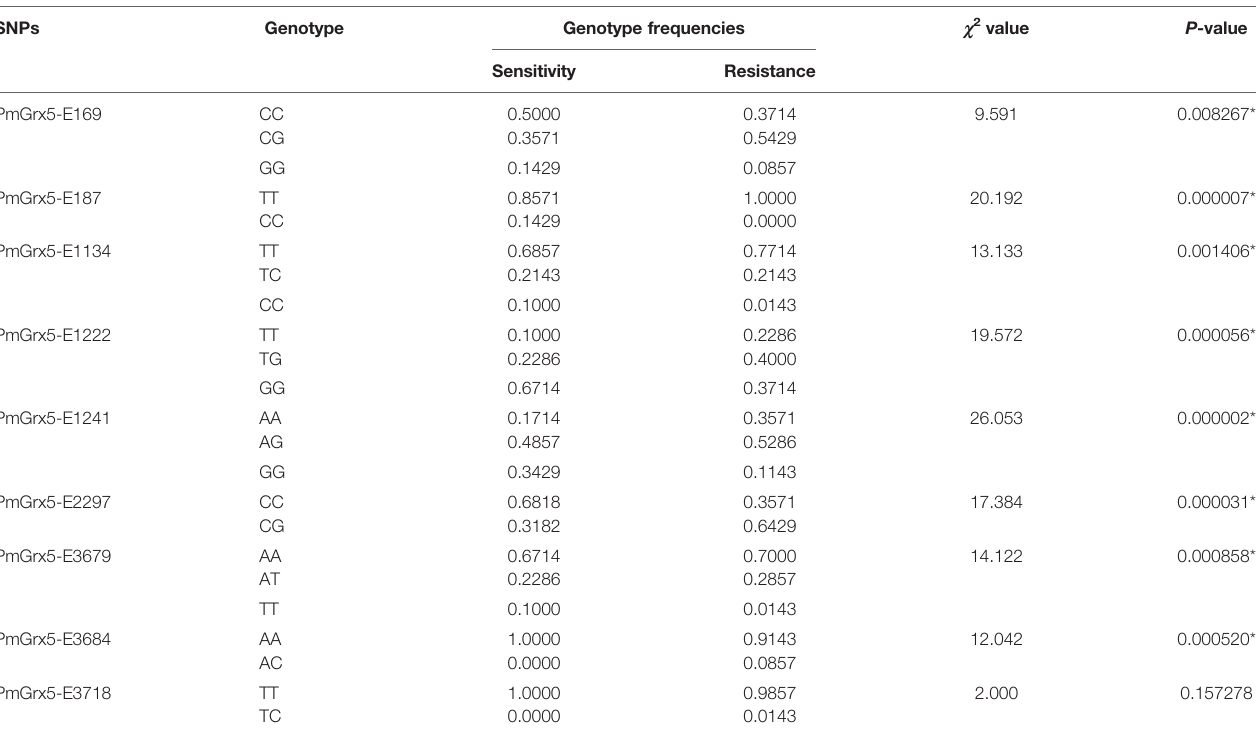
TABLE 4 | Correlation analysis between the SNPs of PmGrx5 and ammonia-N stress tolerance trait.